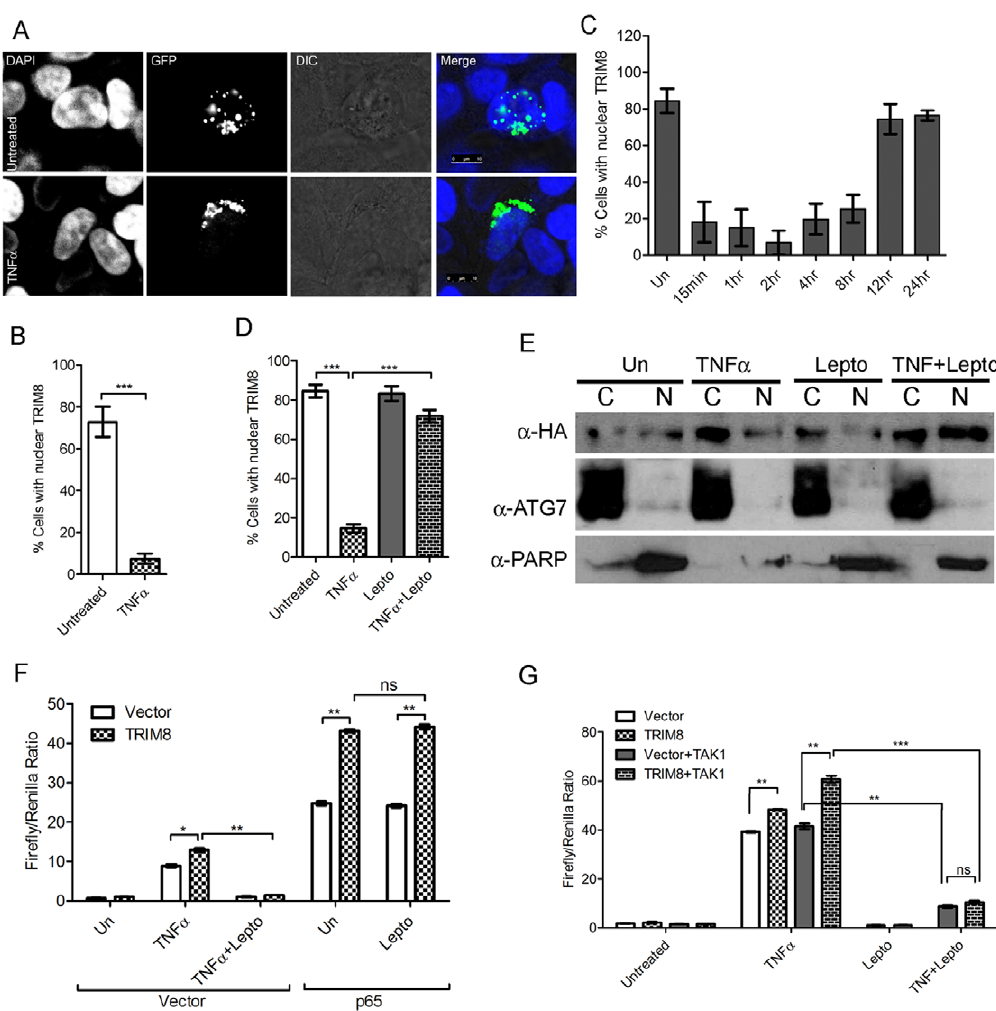
Figure 4. Nucleo-cytoplasmic translocation of TRIM8 is involved in regulation of NF- k B. (A) TRIM8 translocates to cytoplasm in the presence of TNF a . HEK293 cells were plated on cover slip and transfected with TRIM8-GFP. After 24 hours of transfection, the cells were treated with TNF a and fixed with 4% paraformaldehyde, stained with DAPI and visualized by confocal microscopy. Scale bar represent 7.5 m M. (B) Quantification of cells showing nuclear positive TRIM8-GFP in untreated and TNF treatment condition. (C) Time course analysis of nucleo-cytoplasmic localization of TRIM8 in response to TNF. Quantification of nuclear TRIM8-GFP positive cells in control and TNF treated conditions at indicated time points. (D) Leptomycin B suppresses TNF mediated cytoplasmic translocation of TRIM8. Quantification of cells showing nuclear TRIM8-GFP in indicated treatment conditions (Lepto=Leptomycin B). (E) Analysis of sub-cellular localization of TRIM8 in control and TNF treated cells. HEK293 cells were transfected with HA-TRIM8, nuclear and cytosolic fractions were isolated as described in materials and method. The fractions were analyzed by western blotting using indicated antibodies. (Lepto=Leptomycin B) (F) Leptomycin B suppresses TRIM8 mediated TNF induced NF- k B pathway. HEK293 was transfected with TRIM8, vector with or without p65, treated with Leptomycin B and NF- k B activation measured by Dual Glo luciferase assay. (Lepto=Leptomycin B) (G) Leptomycin B suppresses TAK1 induced NF- k B pathway. HEK293 was transfected with indicated constructs and NF- k B activation measured by Dual Glo luciferase assay (Lepto=Leptomycin B). Asterisk (*) indicates data changes are statistically significant between groups: p value , 0.05 for SEM of minimum three independent experiments.